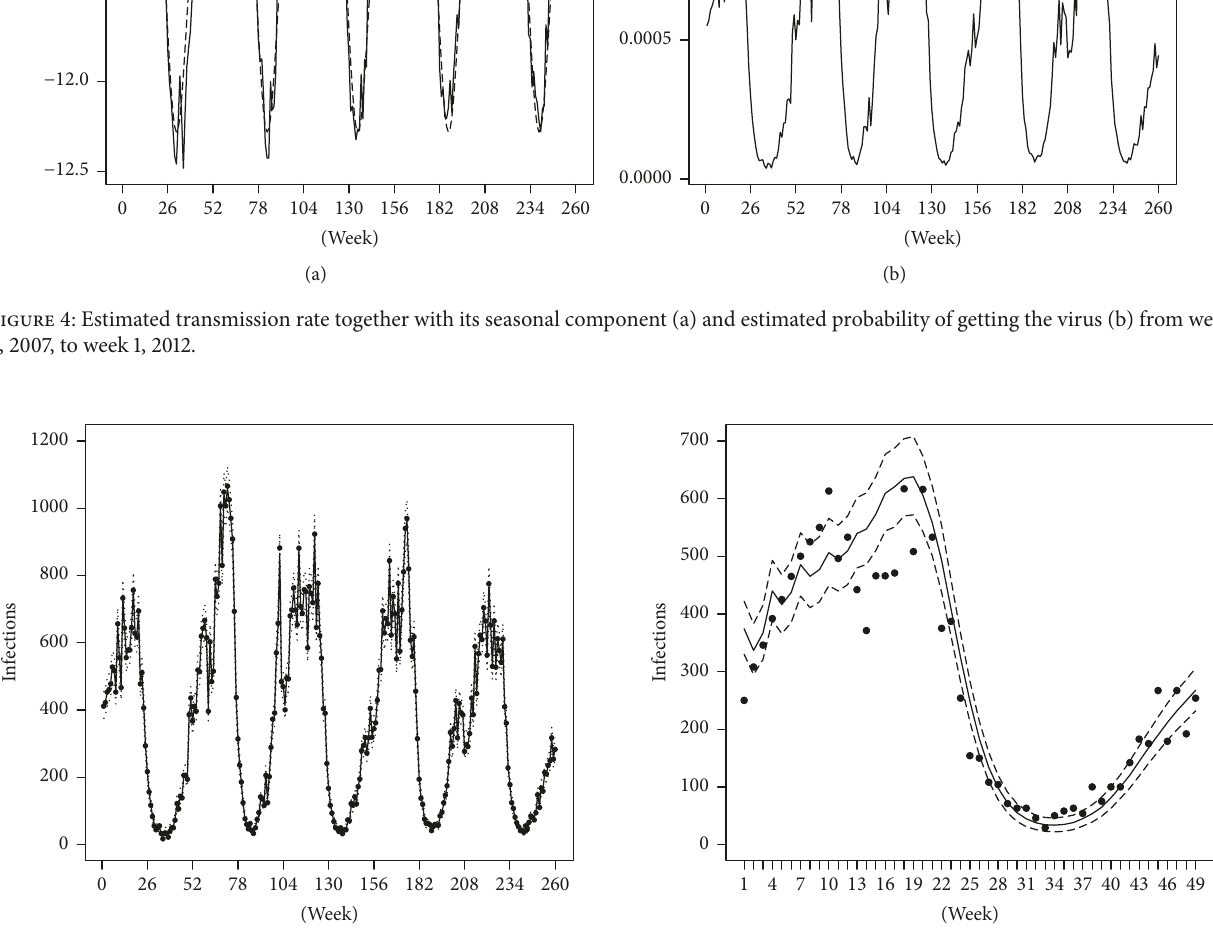
Figure 6: Point forecasts (solid line) together with 95 % prediction intervals (dashed lines) for the last 49 weeks of 2012 (from week 4 to week 52, 2012). Solid points represent cases of chickenpox reported by the health sentinel network in the Valencian